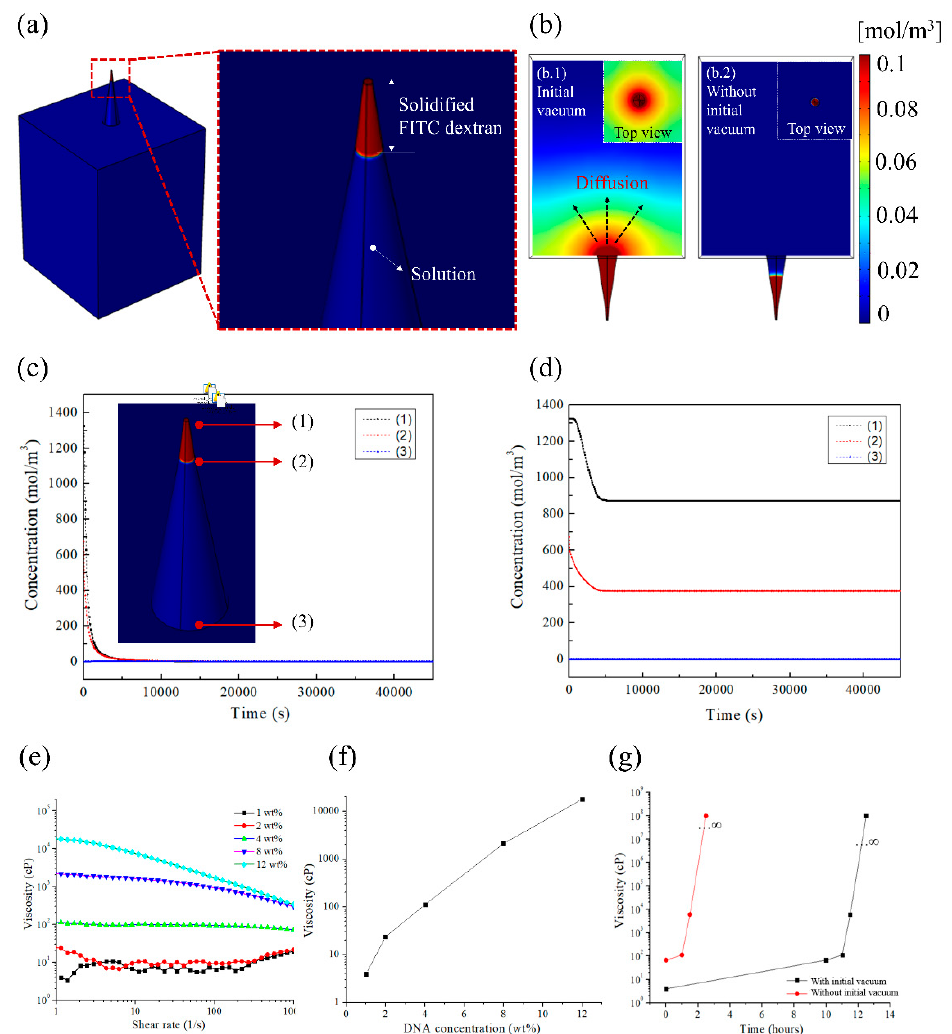
Figure 4. Di ff usion simulation of the needle fabrication process. ( a ) Mold with FITC and DNA solution. The enlarged image shows the 200- µ m high solidified FITC and 800- µ m high DNA solution in the mold (time = 0 s, the interface before spread between the drug-loaded tip and top-up solution). ( b ) Needle di ff usion after 45,000 s (b.1) with initial vacuum and (b.2) without initial vacuum. Graph of drug distribution by needle position over time ( c ) when initial vacuum was implemented; the inset image indicates positions 1, 2, and 3, respectively, and ( d ) when initial vacuum was not implemented. ( e ) Steady shear viscosity with shear rates for di ff erent DNA concentrations. ( f ) Viscosity values with the DNA concentration. ( g ) Relationship between DNA viscosity and actual drying time determined using an interpolation plot (when DNA and FITC are in contact).